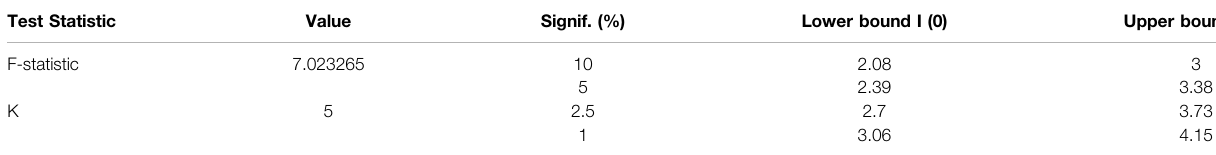
TABLE 4 | Bounds test results.